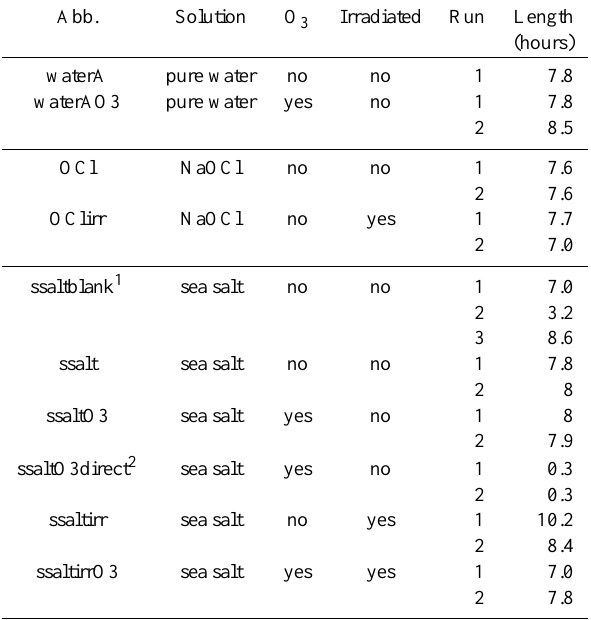
Table 1. Experiments to investigate isotopic fractionation during oxidation of SO 2 on sea salt aerosol. 1 SO 2 flow was replaced with synthetic air to measure sulfate in sea salt samples that had not been exposed to SO 2 . 2 Collected directly on a gold-coated filter and anal- ysed in the NanoSIMS without extracting to BaSO 4